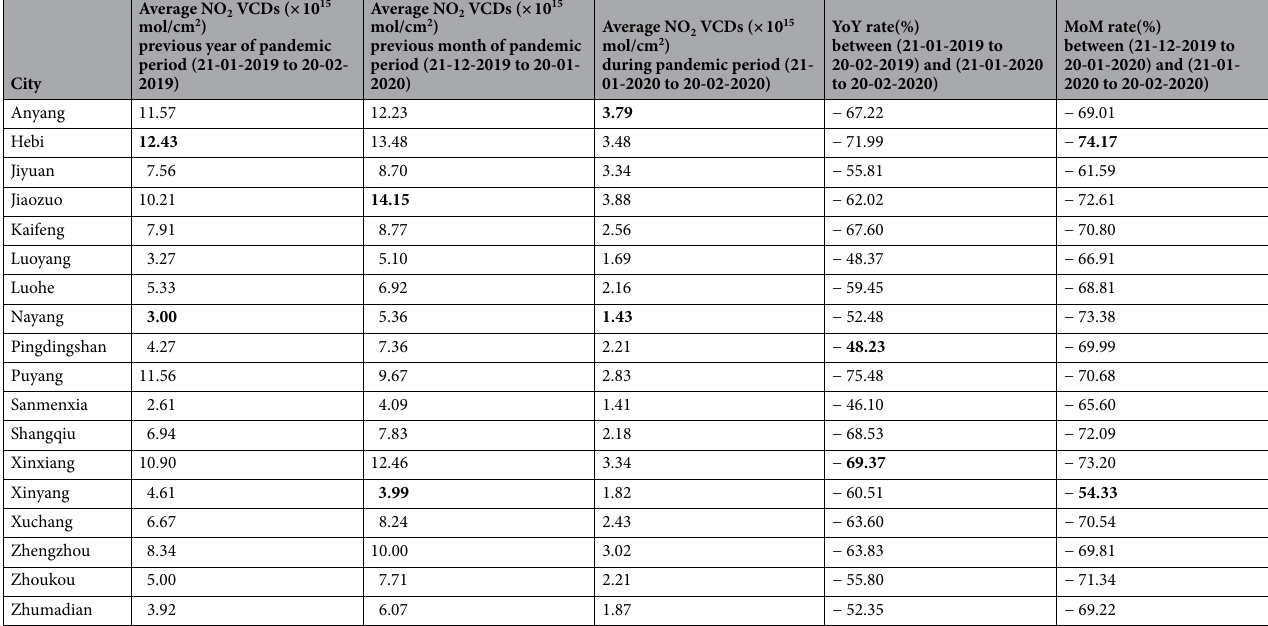
Table 1. The NO 2 VCDs of COVID-19 pandemic period in 18 urban areas of Henan Province. The bold numbers represent the maximum and minimum values of the values in each